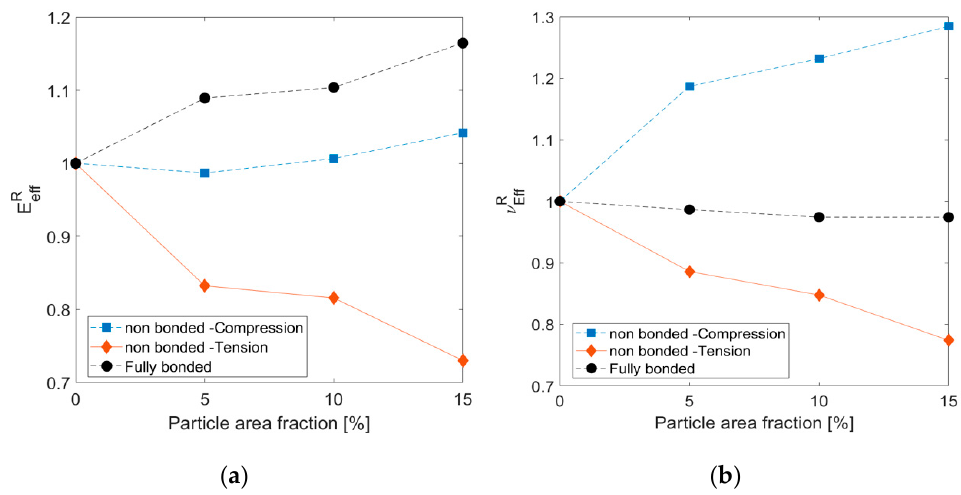
Figure 9. Relative effective elastic modulus ( a ) and Poisson’s ratio ( b ) for nonbonded interface for different particle volume fraction values under different loading and interface conditions compared to fully bonded case.